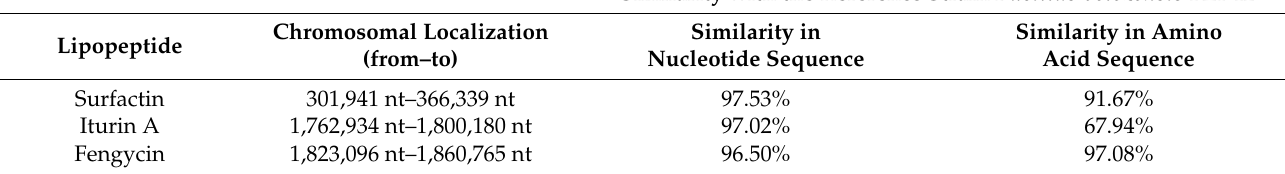
Table 1. Comparison of the gene clusters encoding NRPS for biosynthesis of the main lipopeptides, surfactin, iturin, and fengycin, in the genomes of Bacillus velezensis UTB96 and the reference strain Bacillus velezensis FZB42. Similarity with the Reference Strain Bacillus velezensis FZB42